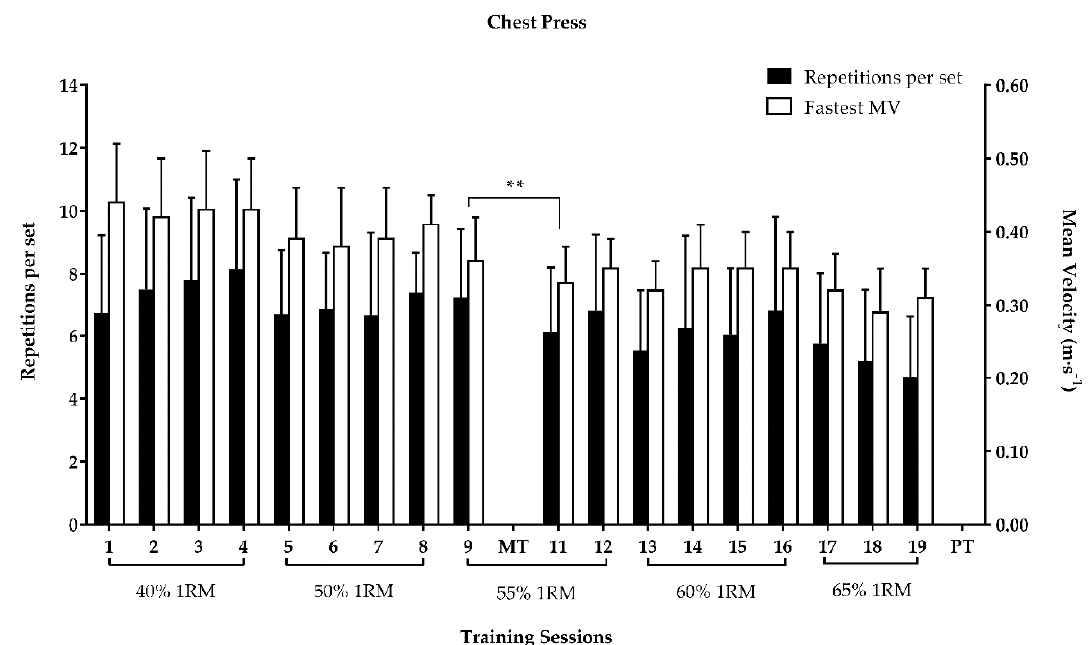
Figure 5. Repetitions per set and fastest MV (mean ± SD) in the chest-press exercise throughout the RT program; 1RM: one-repetition maximum; MT: 1RM mid-test load adjustment; MV: mean velocity; PT: post-test; ** p -value < 0.01 for the fastest MV.